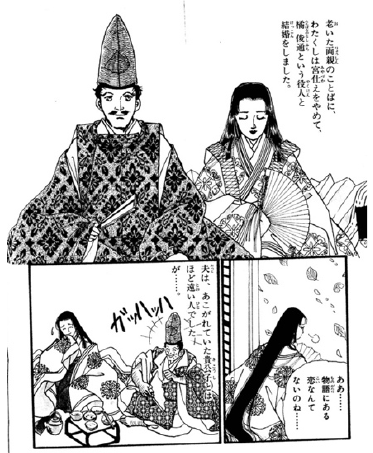
Figure 9. Hime gets married and accepts that there is not fairytale romance in real life (Kōzuki 1993, 106). Courtesy of Kumon